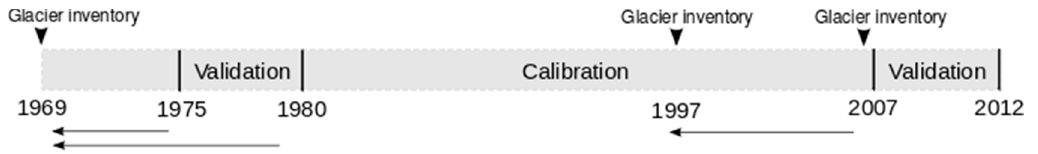
Figure 2. Time bar to illustrate periods of calibration and validation, date of glacier inventories, and spin-up periods (arrows below).